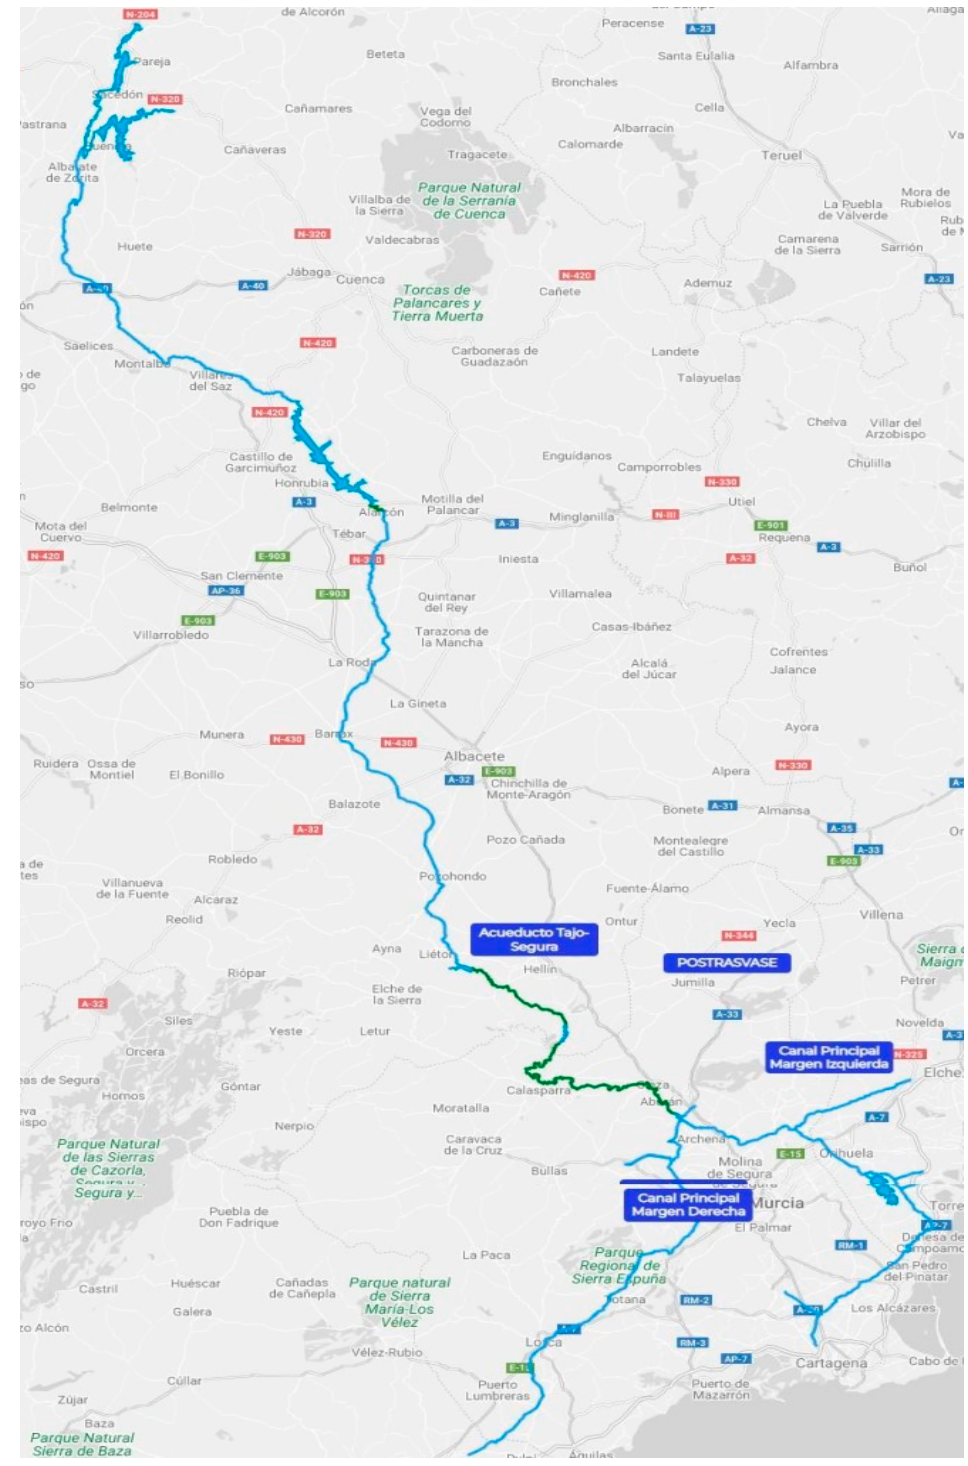
Figure 1. Map of the Tagus ‐ Segura water transfer system. Source: [32].